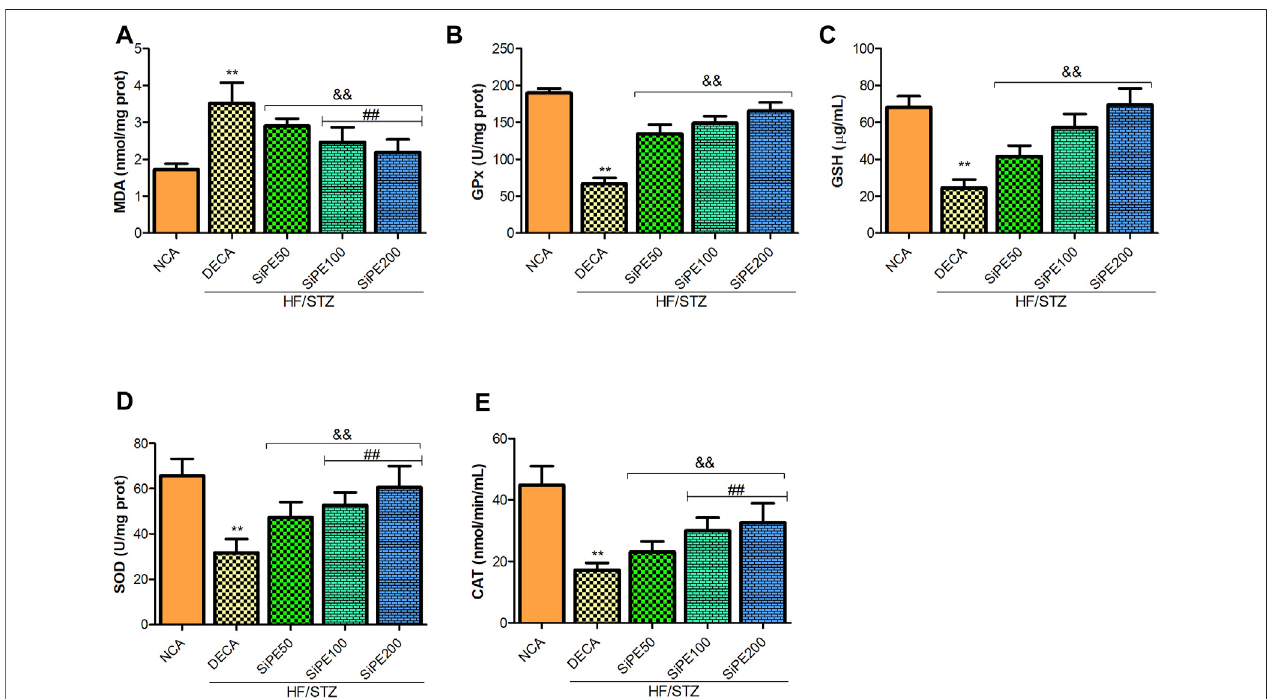
FIGURE 6 | Effect of SiPE treatment on oxidative stress/antioxidant biomarkers in HF/STZ-induced diabetic encephalopathic rats. SiPE treatment at doses of 50, 100or200 mg/kgcausedsigni fi cantdecreasein (A) brainmalondialdehyde(MDA)levelscomparedtoDECAgroup.SiPEtreatmentreversedHF/STZinducedreduction in (B) brainglutathioneperoxidase(GPx), (C) reducedglutathione(GSH), (D) superoxide dismutase(SOD)and (E) catalase(CAT).Dataarepresentedasmean ± SD( n (cid:2) 6) and one-way ANOVA test was applied. ** p < 0.001 indicates statistical signi fi cance compared to NCA group. ## p < 0.001, && p < 0.01 and $$ p < 0.05 indicate statistical signi fi cance compared to DECA